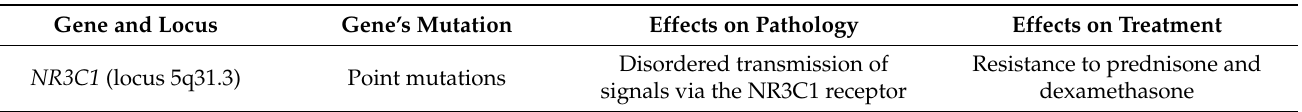
Table 2. Characteristics of genes, their mutations, and pathological and treatment effects responsible for steroid, MTX, and asparaginase resistance. Gene and Locus Gene’s Mutation Effects on Pathology Effects on Treatment Resistance to prednisone and NR3C1 (locus 5q31.3) Point mutations signals via the NR3C1 receptor